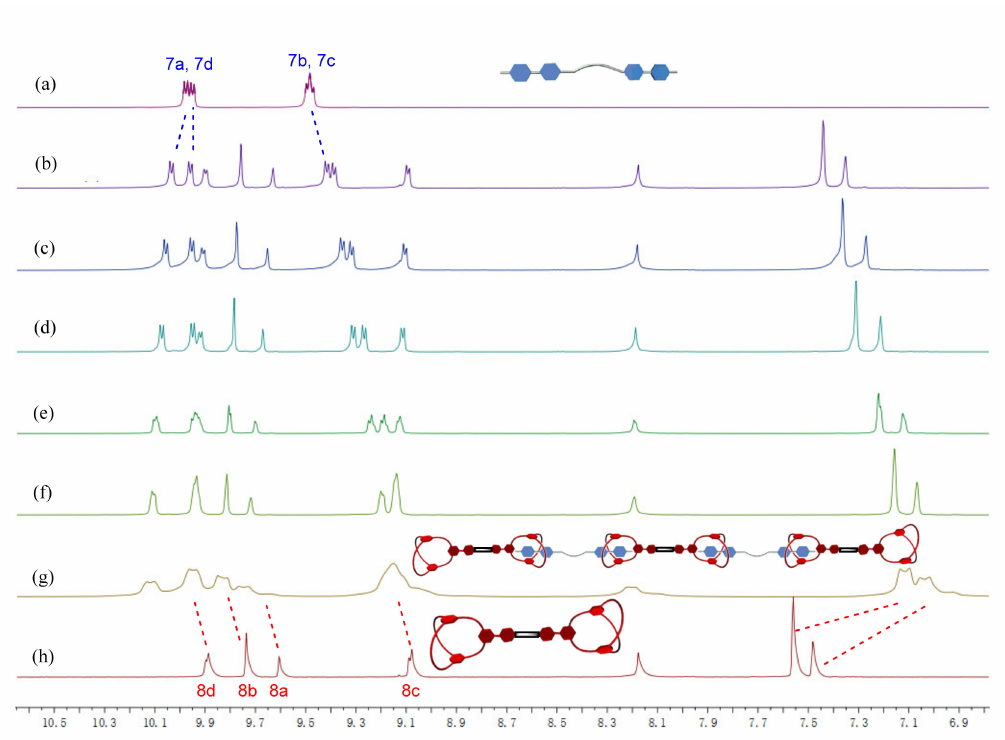
Figure 5. Partial 1 H NMR spectra [500 MHz, CD 2 Cl 2 /CD 3 NO 2 (1:1, v/v ), 298 K]: ( a ) 7 ; (b–g) solutions of 7 and 8 with 1:1 molar ratio at concentrations of ( b ) 2.50 mM, ( c ) 5.00 mM, ( d ) 10.0 mM, ( e ) 25.0 mM, ( f ) 50.0 mM, ( g ) 100.0 mM; ( h ) 8 . The assignments of protons were shown in Scheme